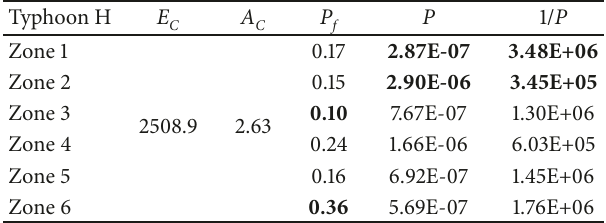
Table 8: Results for Typhoon H.